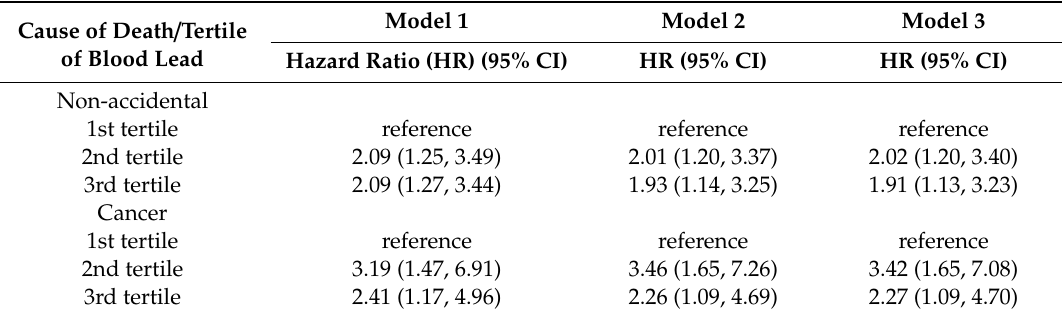
Table 2. Hazard ratio (95% CI) of non-accidental and cancer mortality associated with tertile of blood